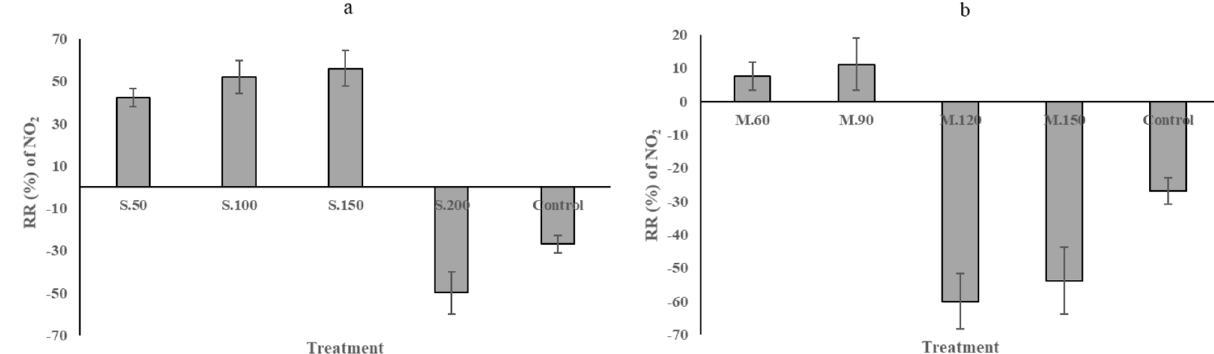
Fig. 7. The removal rates, averages and error bars of the four replications, of NO 2 (%) in the control and at four densities of G. verucosa (a) and P. viridis (b).